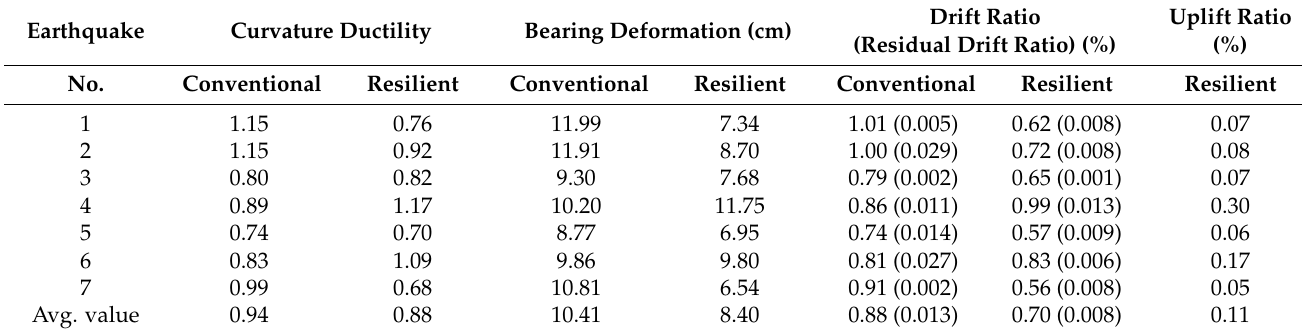
Table 1. Maximum seismic responses of RC bridges at E1 level.